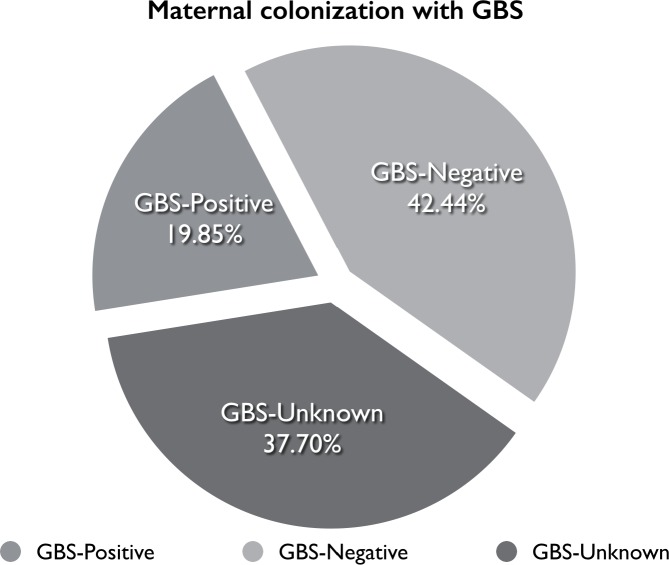
Maternal Colonization with GBS.